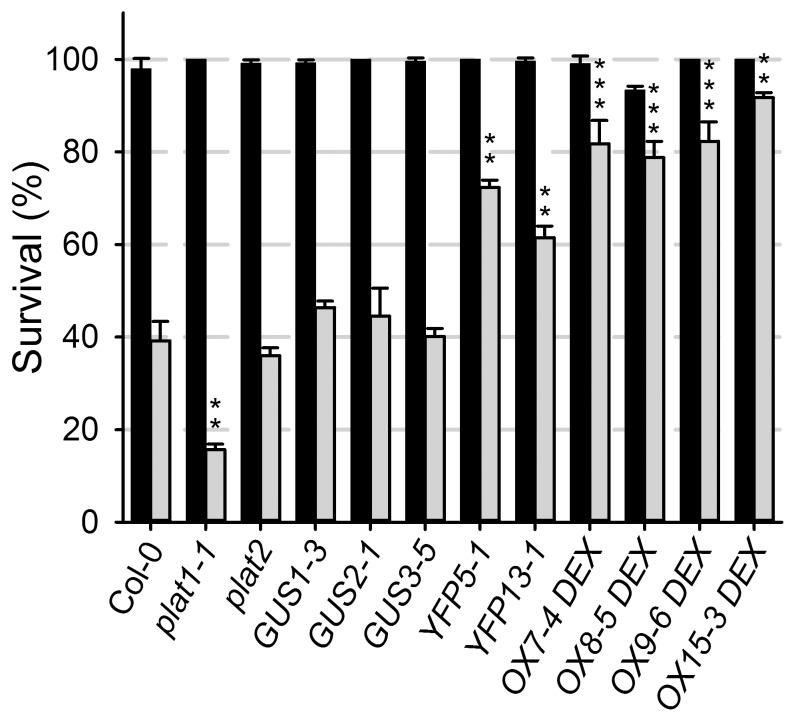
PLAT1 promotes tolerance towards tunicamycin elicited ER stress.Survival is expressed as the percentage of the plated seeds that developed (pale) green seedlings. Control conditions black bars, ER stress (0.05 µg l−1 TM) grey bars. Values are means of 3 replicates ± standard deviation. n≥70 per replicate. *** or ** indicate statistical significance calculated using the unpaired Student's t-test at p<0.001 or p<0.01, respectively.